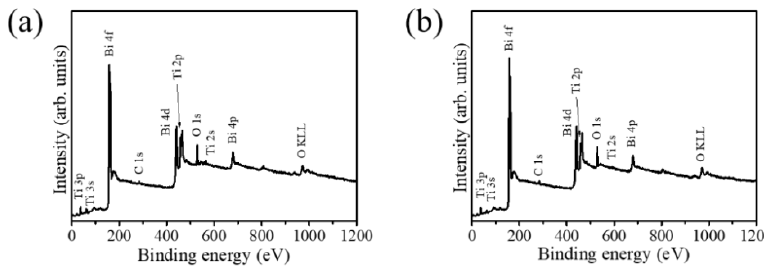
Figure 5. X-ray photoelectron spectroscopy (XPS) analysis: ( a ) TiO 2 /s – Bi 2 O 3 and ( b ) TiO 2 /a – Bi 2 O 3 rods.